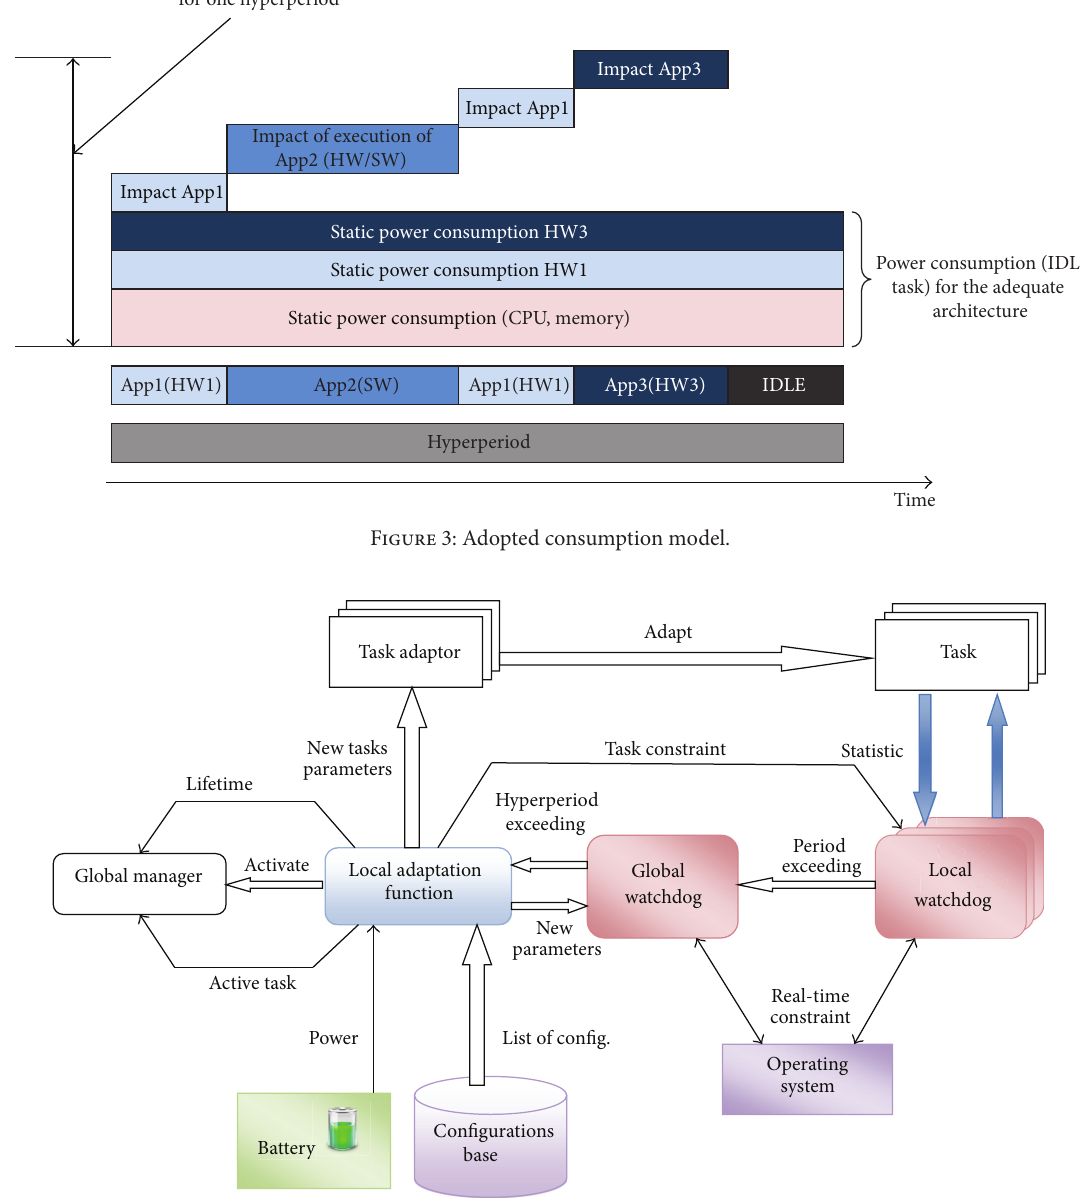
Figure 4: Real-time control